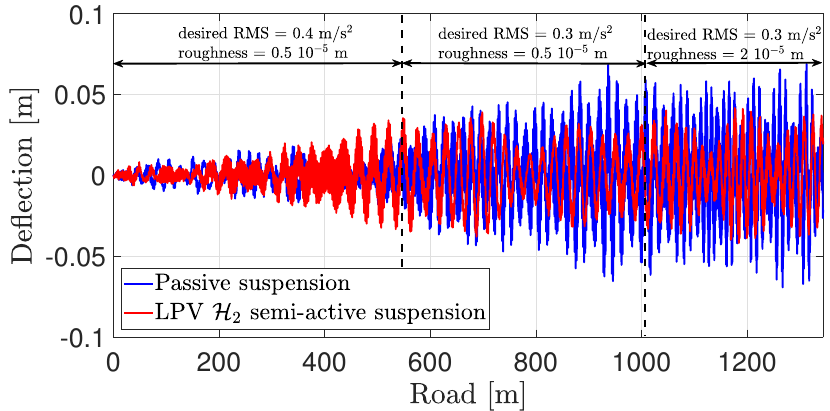
Figure 23. Resulting deflection at the front right corner.